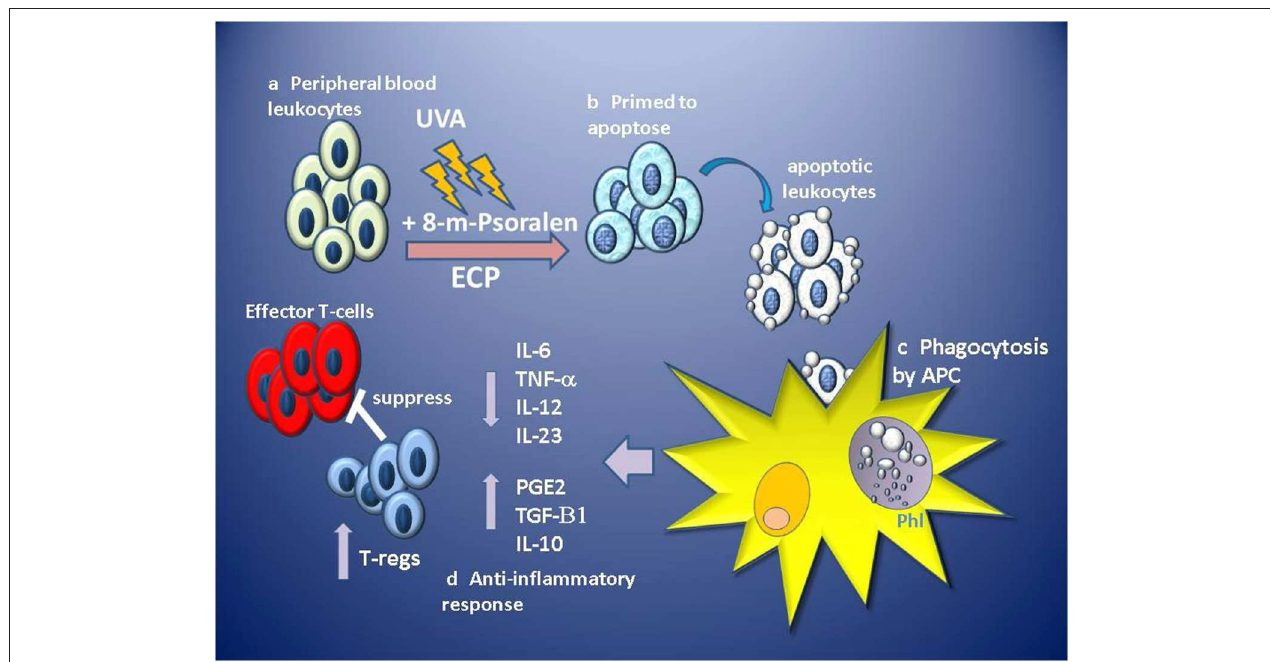
FIGURE 1 | Stages of proposed primary hypothesis for mechanism of immunomodulation of GVHD by ECP. (a) Apheresed peripheral blood leukocytes are separated from red blood cells and concentrated before exposure to 8-methoxypsoralen (8-m-psoralen) and photoactivated by UV-A light (UVA). (b) ECP-treated leukocytes now primed to die by apoptosis are infused into the circulation. (c) Apoptotic leukocytes are recognized, engulfed and phagocytosed by antigen presenting cells (APC: macrophages and dendritic cells) in phagolysosomes (Phl). (d) Recognition of apoptotic cells induces an anti-inflammatory tolerogenic response by APCs resulting in lower production of pro-inflammatory cytokines IL-6, IL12, IL-23, and TNF α and induces production of anti-inflammatory IL-10, TGF- β 1, and prostaglandin E2 (PGE2). Tolerogenic APCs promote the priming and expansion of regulatory T-cell (T-regs), which suppress the function of alloantigen-specific effector T-cells involved in